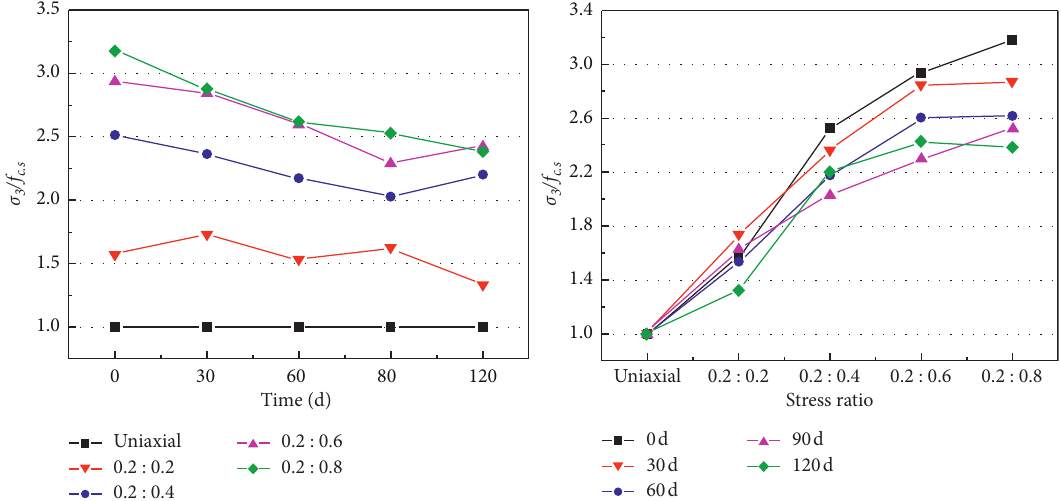
Figure 12: Variation of σ 3 / f c , s under different erosion time and stress